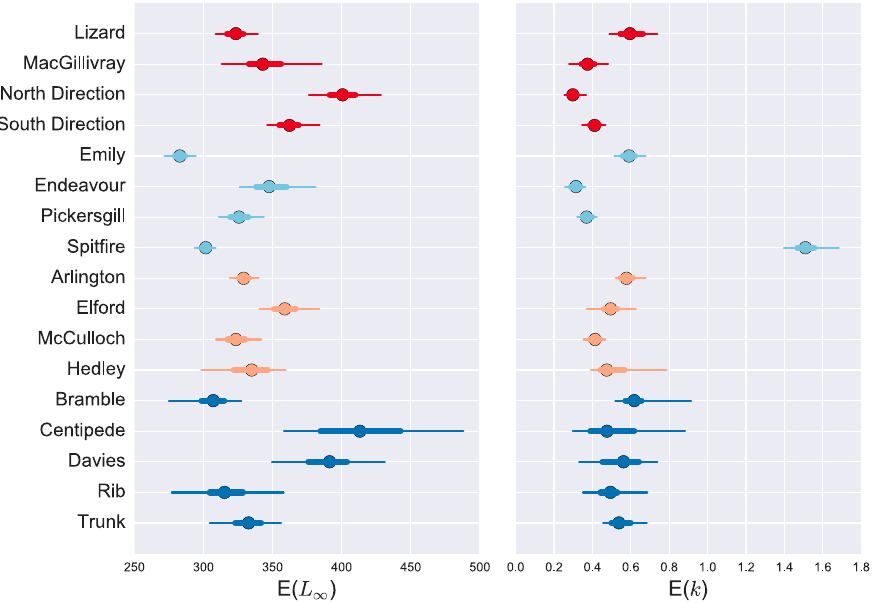
Figure 3. Bayesian hierarchical von Bertalanffy parameter posterior effect sizes for the relationship between band counts and observed diameter of CoTS collected in the Great Barrier Reef CoTS initiation box, 2013–2014. Points are highest posterior density medians, with 50% (thick lines) and 95% (thin lines) uncertainty intervals. Plot includes reefs sampled from the northern initiation box (red), central initiation box (light blue), southern initiation box (tan), and southern outbreak edge (dark blue).